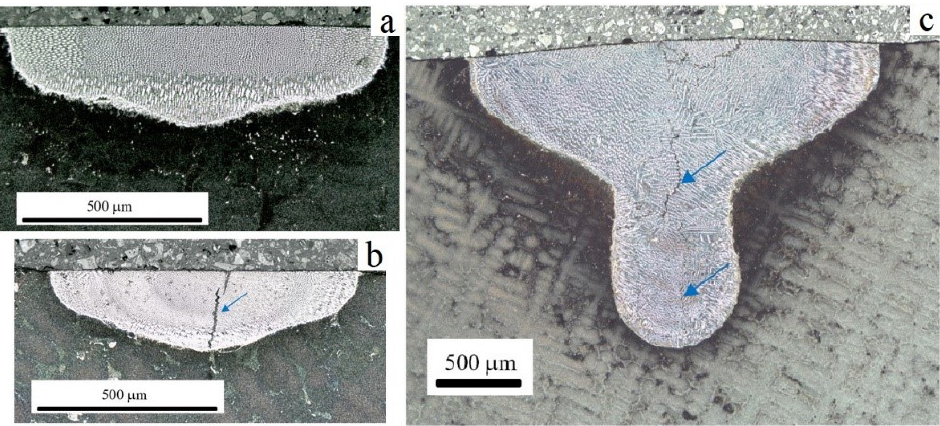
Figure 3. The structure of samples after laser melting: ( a ) sample without defects (process parameter 200 W 3 mm/s); ( b , c ) samples with cracks (process parameter 200 W 9 mm/s and 600 W 9 mm/s, respectively).